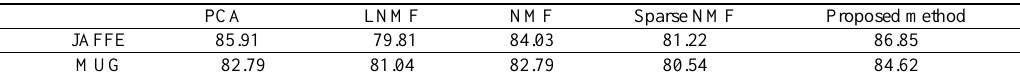
Table 1. Comparison of PCA, NMF, LNMF, sparse NMF, and the proposed method in term of classification